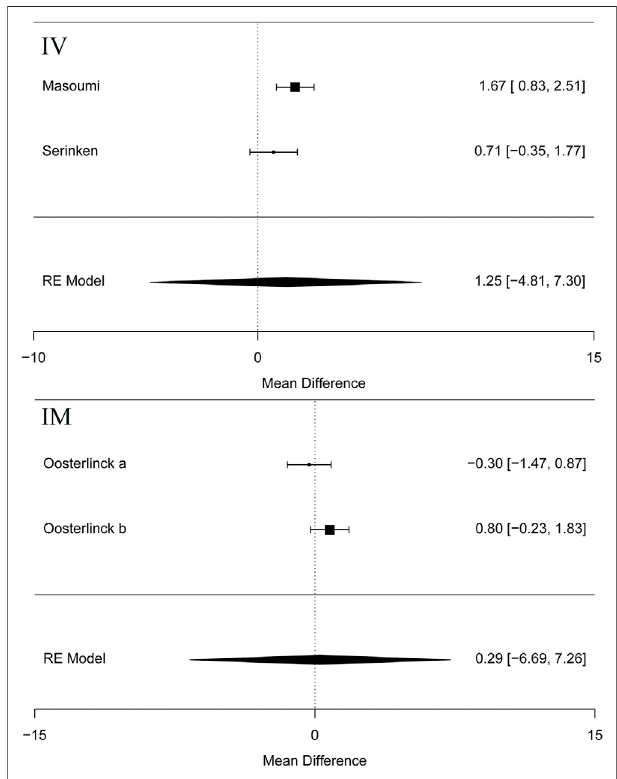
FIGURE 3 | The results of meta-analysis for changes in pain scores (VAS) at 0 – 30 min based on different routes.